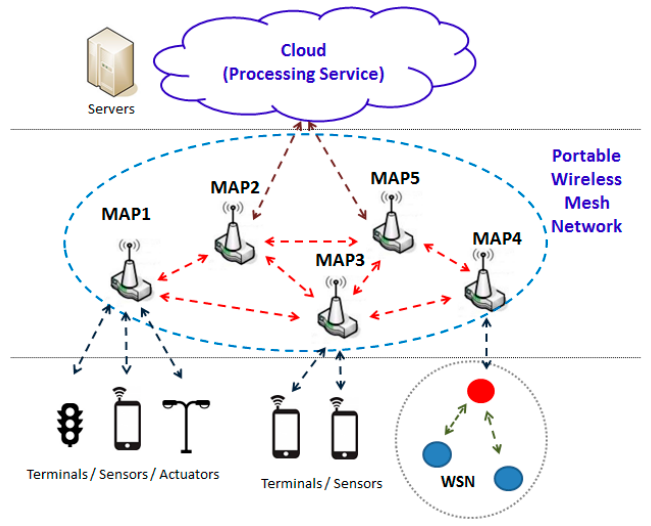
Figure 1. System architecture for sensor data traffic in a smart city.